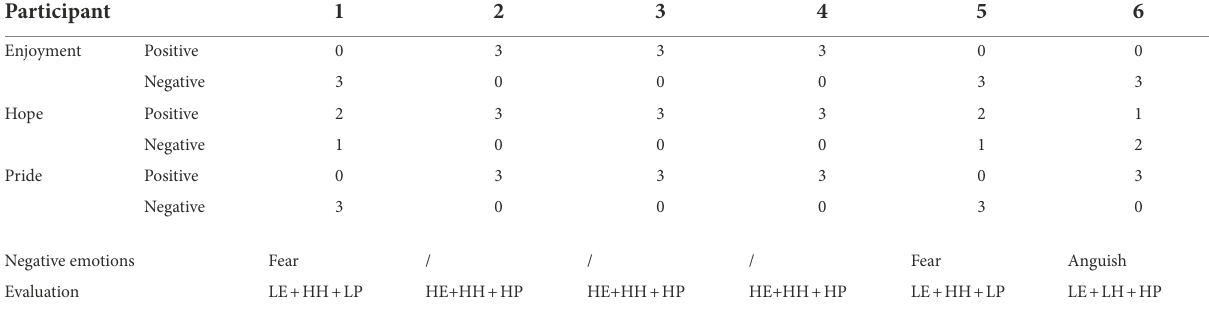
TABLE 2 Participants’ achievement